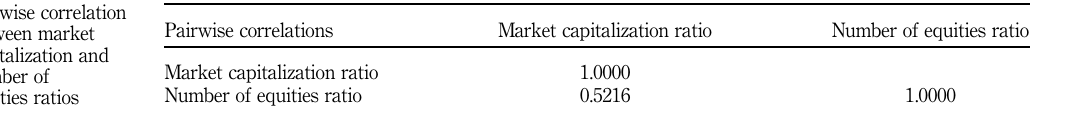
Table III. Illustration of eigenvalues of Component 1 and Component